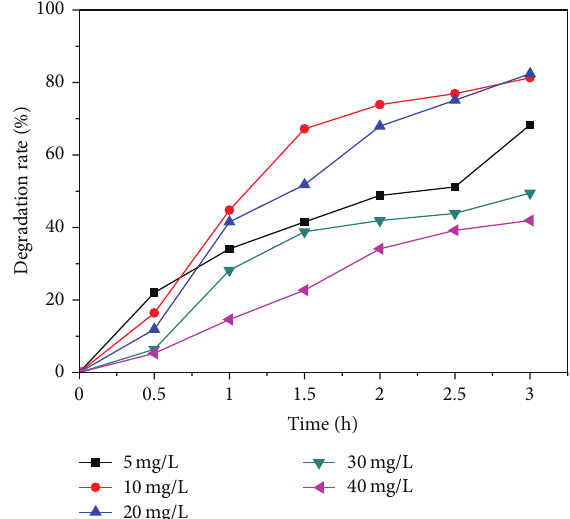
Figure 4: Effect of the initial methyl violet concentration on the photocatalytic degradation rate of methyl